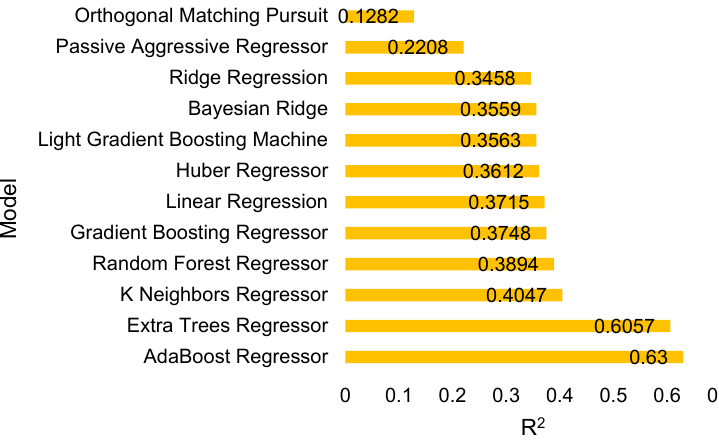
Figure 14. KPI based performance comparison of different models.